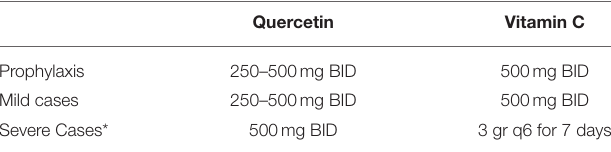
TABLE 1 | Proposed multi-drug approach for either the prophylaxis for high risk population, and treatment of mild and severe cases. Quercetin Vitamin C